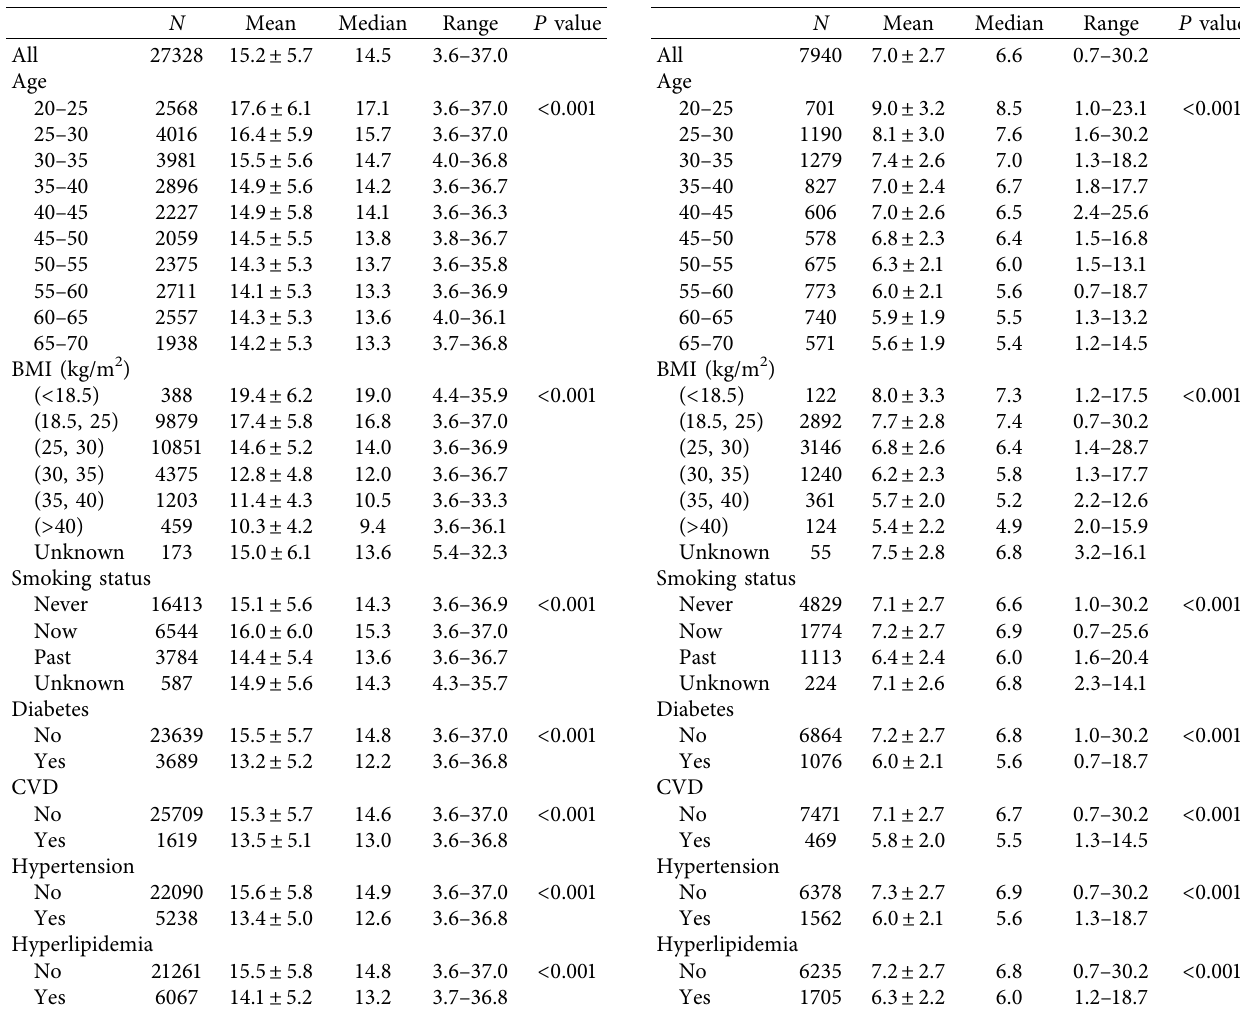
Table 1: Total testosterone levels stratified by age, BMI, smoking status, diabetes, CVD, hypertension, and hyperlipidemia.